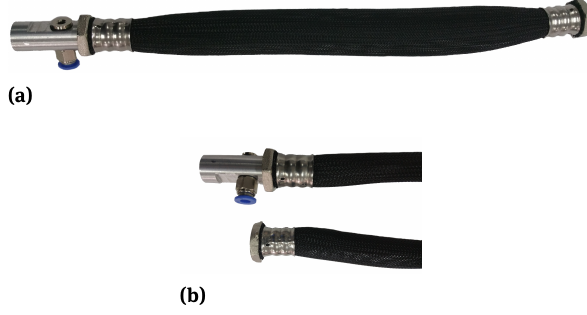
Figure 2: Pneumatic artificial muscles made at the Kielce University of Technology: a) general view, b) connections – clamping